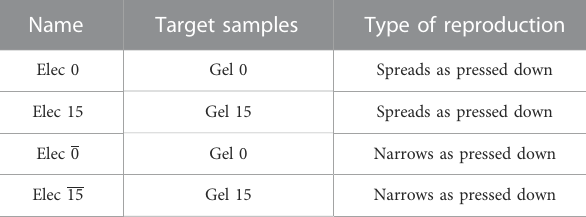
TABLE 1 Four types of electrical stimulation patterns.